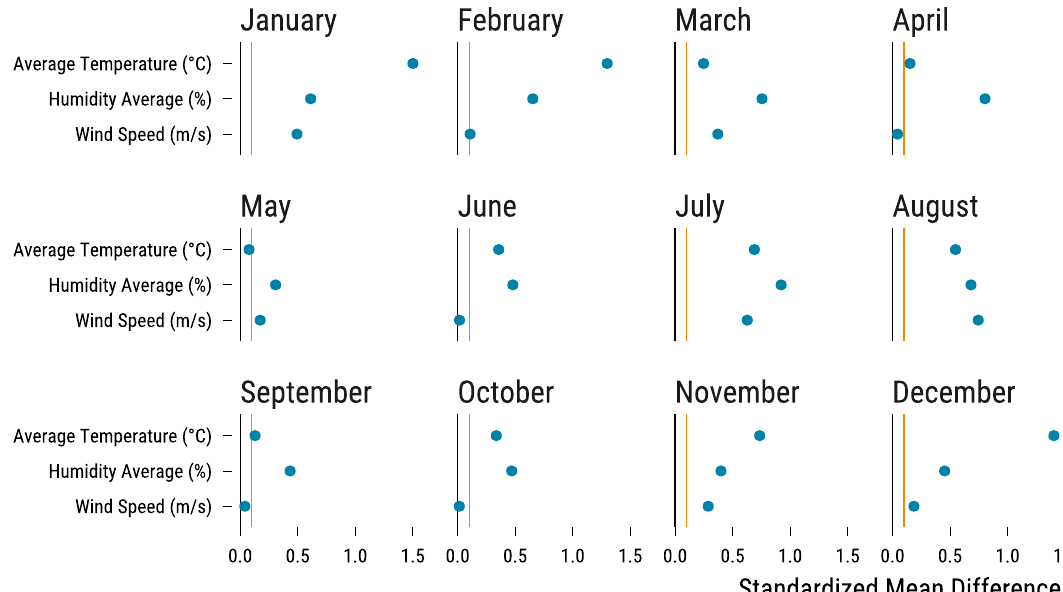
Figure 3. Evidence of imbalance for weather covariates . For each month, we compute the absolute standardized differences for continuous weather covariates between treated and control groups. These differences are represented as blue points. The vertical orange line is the 0.1 threshold which is used in the matching literature to spot covariates imbalance. The vertical black line is at